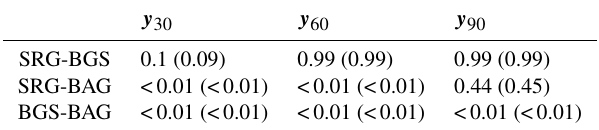
Table 1. p values for the null hypothesis “the simple model out- performs the complex model”, estimated by a right-sided t test (paired differences with mean difference µ and alternative hypoth- esis µ > 0). Paired differences here follow the rule that E MSP of the more complex model is subtracted from E MSP of the less com- plex model, as specified in the first column. In parentheses also the probabilities P { µ > 0 } according to a nonparametric bootstrap with 10000 replicates are listed. Only E MSP from the outer cross- validation is considered; n = 66.